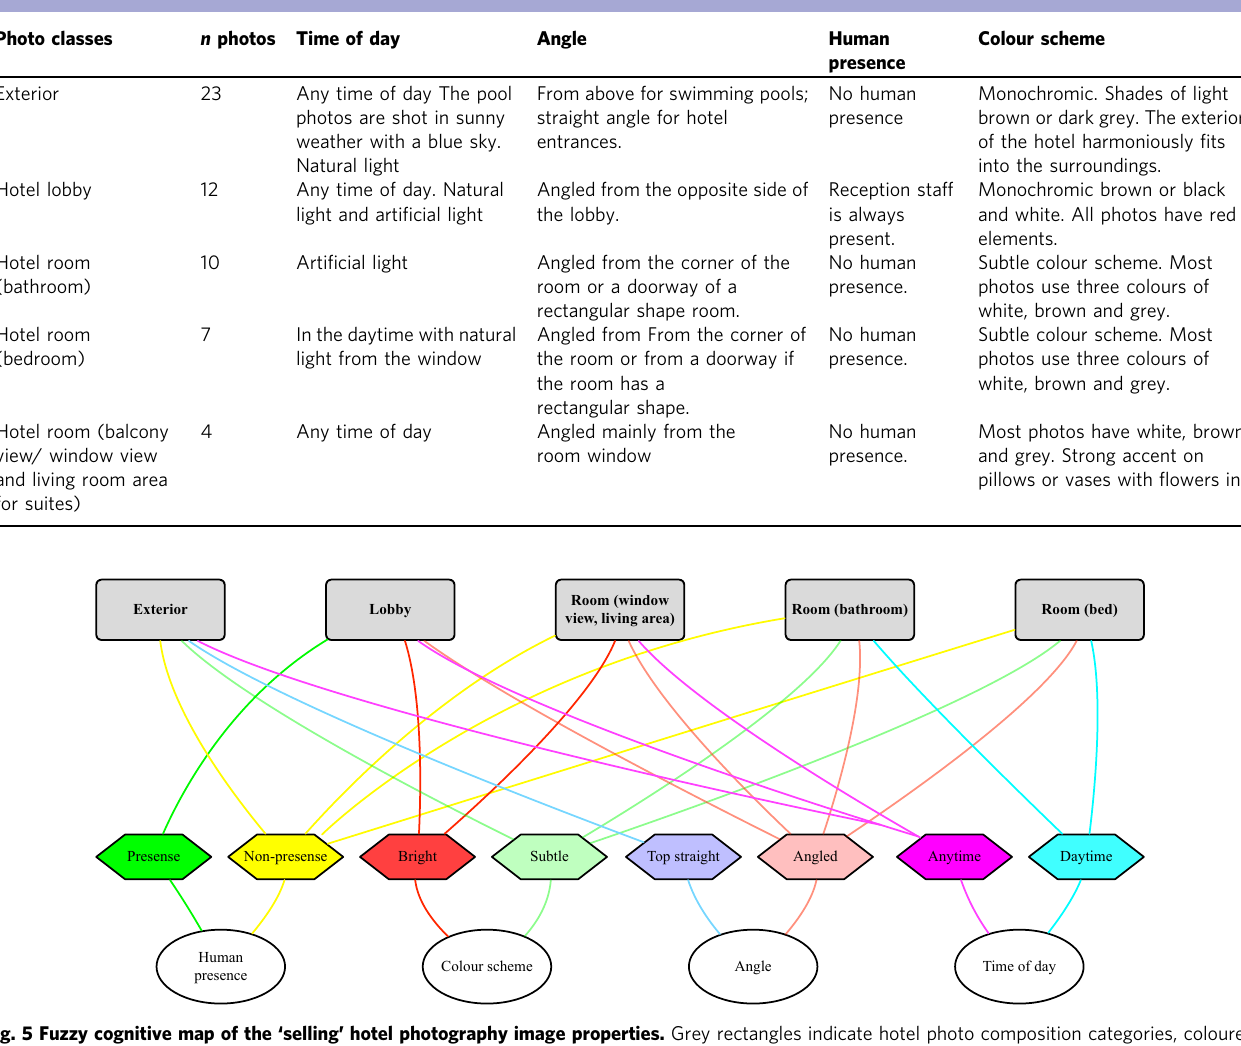
Table 3 Taxonomy of the ‘ selling ’ hotel photo image properties determined by AI.